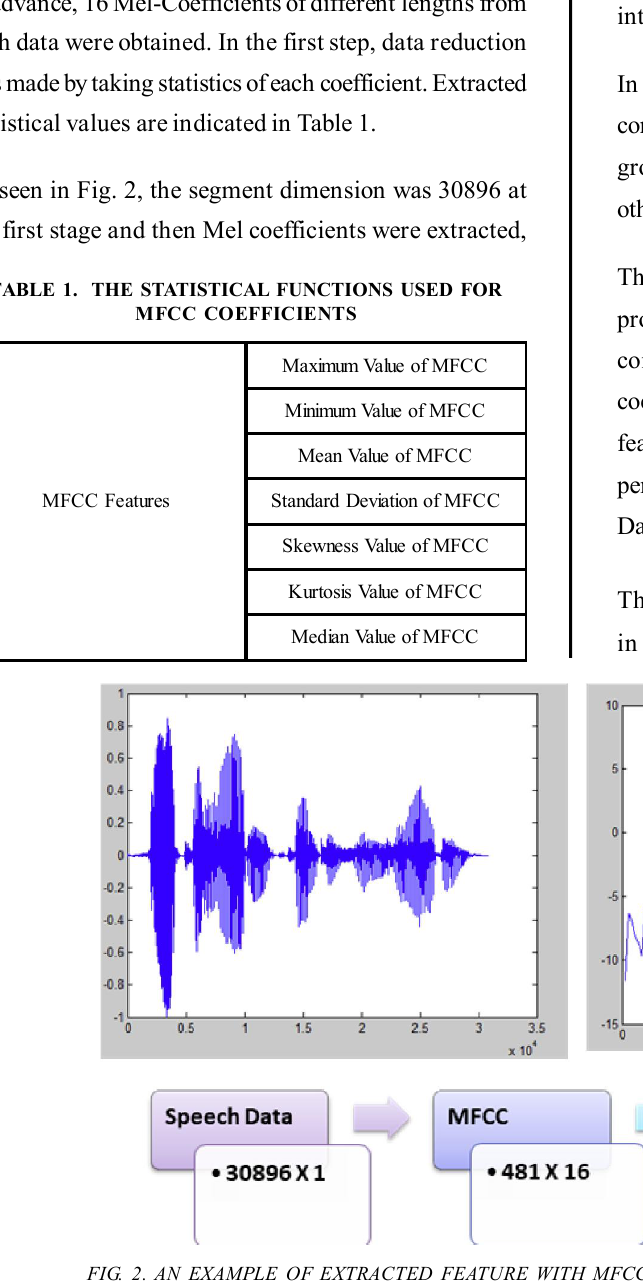
FIG. 2. AN EXAMPLE OF EXTRACTED FEATURE WITH MFCC USING A RANDOMLY SELECTED SEGMENT